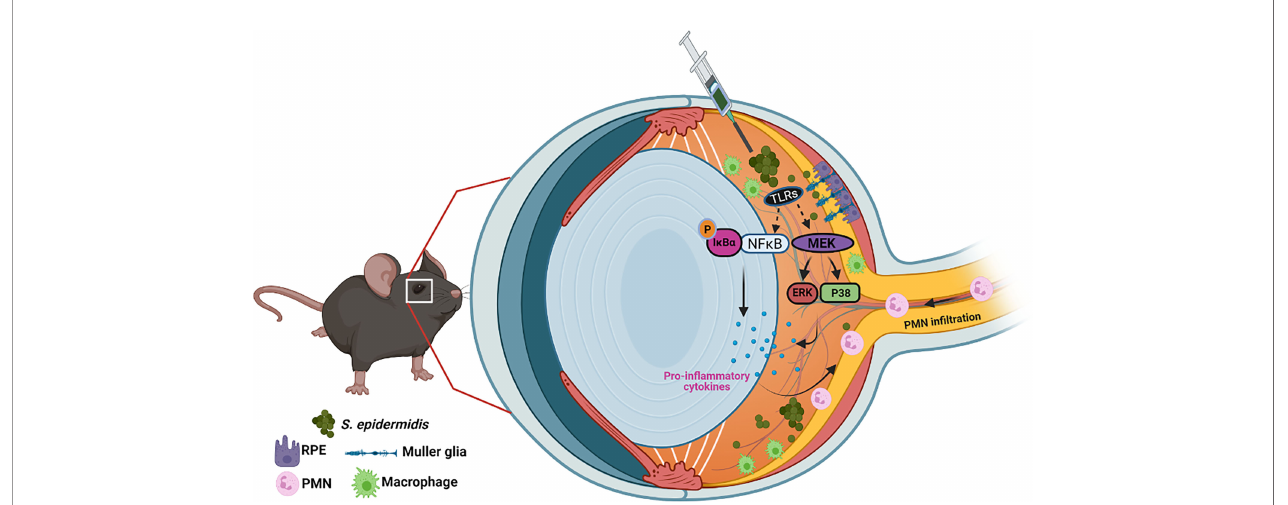
FIGURE 8 | Schematic of pathobiology of S. epidermidis endophthalmitis. Intraocular inoculation of S. epidermidis is recognized by TLRs expressed on in fi ltrating immune cells such as monocytes/macrophages, retinal residential cells, Muller glia, and RPE. Upon activation of in fl ammatory signaling, these cells secrete in fl ammatory cytokine and chemokines to recruit PMNs. Although essential to control bacterial growth, increased in fl ammation and PMN in fi ltration cause collateral retinal tissue damage during endophthalmitis, culminating in reduced visual function and